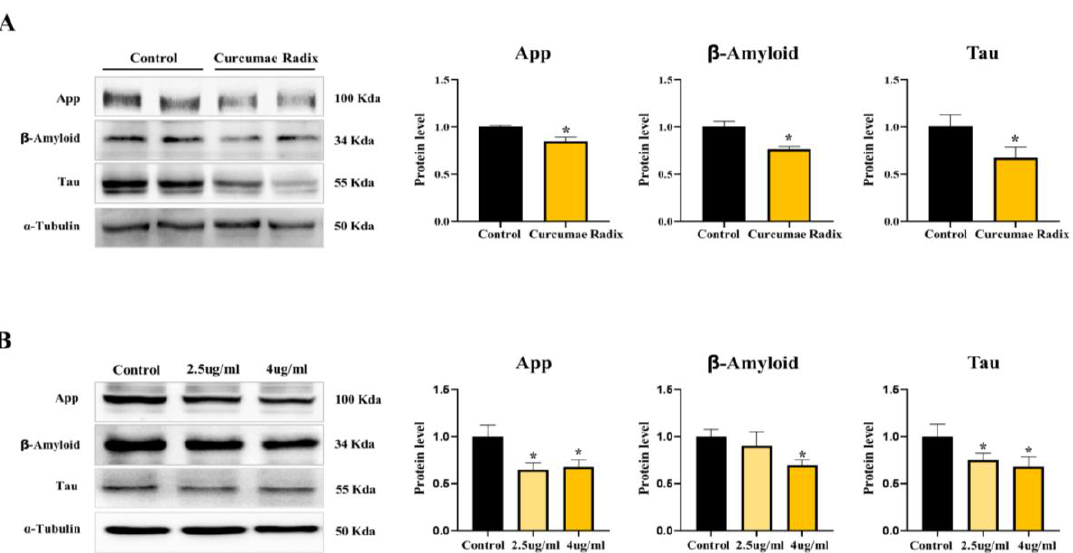
Figure 2. Curcumae radix reduces neurodegenerative markers. ( A )Western blot analysis and quan- tification of Alzheimer’s disease-related genes were evaluated in the cerebrum of CRE-treated male mice. Alpha-Tubulin was used as an internal control. ( B ) Western blot analysis and quantification of Western blot analysis and quantification of Alzheimer’s disease-related genes were evaluated in delayed brain tumor (DBT) cells of CRE-treated mice. Alpha-Tubulin was used as an internal control. The CRE group was treated with CRE 2.5 μg /mL and 4 μg /mL. The values stand for means ± S.D. * p < 0.05 was compared to groups indicated. All experiments were repeated at least 3 times.